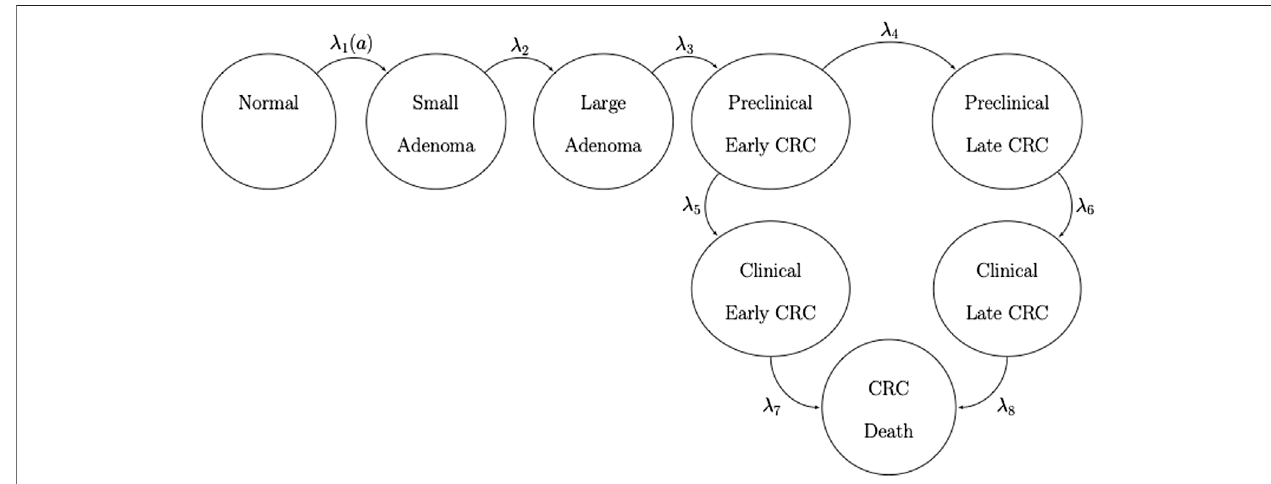
FIGURE 1 | State-transition diagram of the nine-state microsimulation model of the natural history of colorectal cancer. Individuals in all health states face an age- speci fi c mortality of dying from other causes (state not shown) (Jalal et al., 2021).